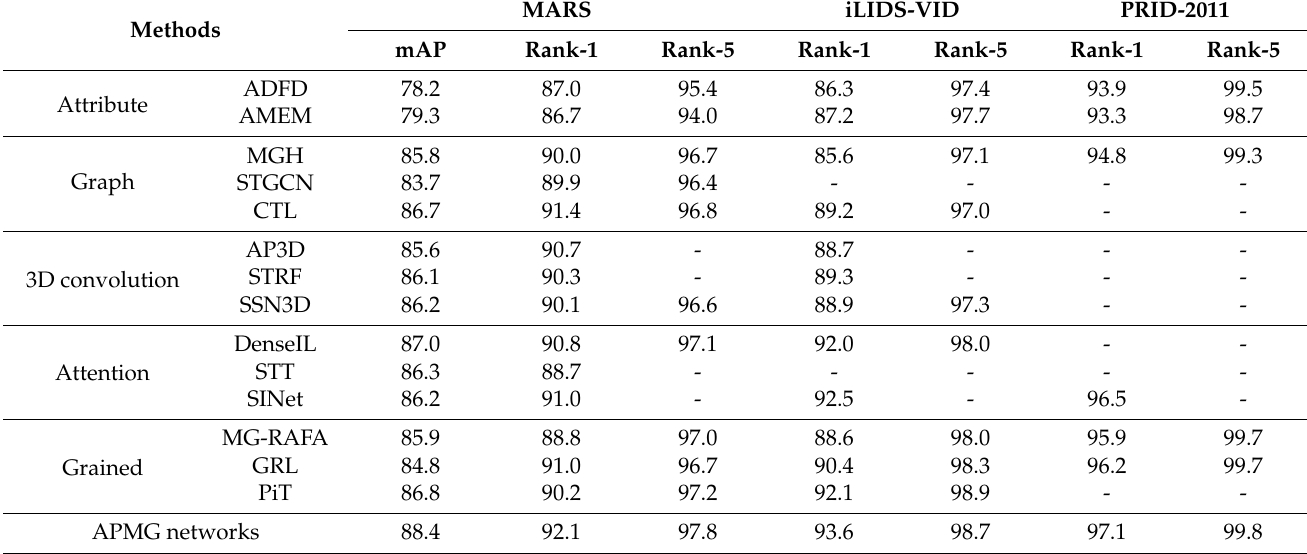
Table 1. The re-identification accuracy of each